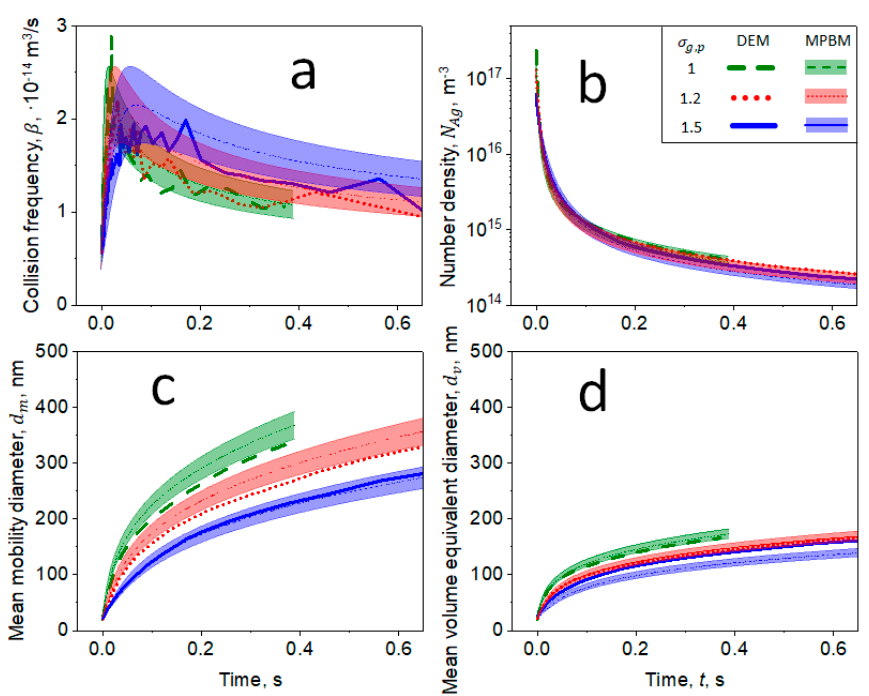
Figure 4. Evolution of ( a ) β , ( b ) number density, N Ag , ( c ) mean d m and ( d ) volume-equivalent diameter, d v , as a function of time, t , for agglomerates consisting of primary particles with mean d p = 20 nm and geometric standard deviation, σ g , p = 1 (broken lines), 1.2 (dotted lines) and 1.5 (solid lines) at T = 1830 K and P = 1 bar estimated by DEM (thick lines) and MPBM (thin lines and shades). All sub-figures ( a – d ) share the same